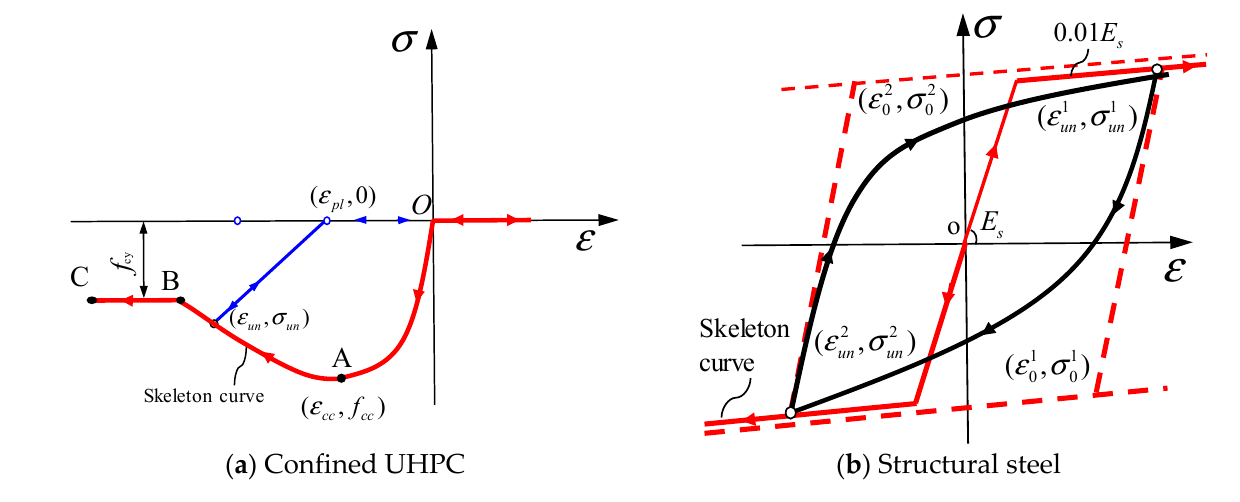
Figure 4. The constitutive models of the two materials. In Equations (5)–(7), β , γ and η are the parameters to determine the descending branch, and ξ is the confinement index of steel tube. ε cc ( µε ) and f cc (MPa) are the compressive peak strain and stress of the confined concrete, respectively. Although Han’s model considers the reinforcing effect of steel tubes on the core concrete, it is only appropriate for normal concrete and high-strength concrete with an f c (MPa) ranging from 24 MPa to 80 MPa. Le’geron and Paultre [19] (2003) proposed the peak stress f cc and the peak strain ε cc of normal and ultra-high strength confined concrete, with an f c ranging from 27 MPa to 124 MPa according to a great quantity of experimental results, and they are given by Equations (8) and